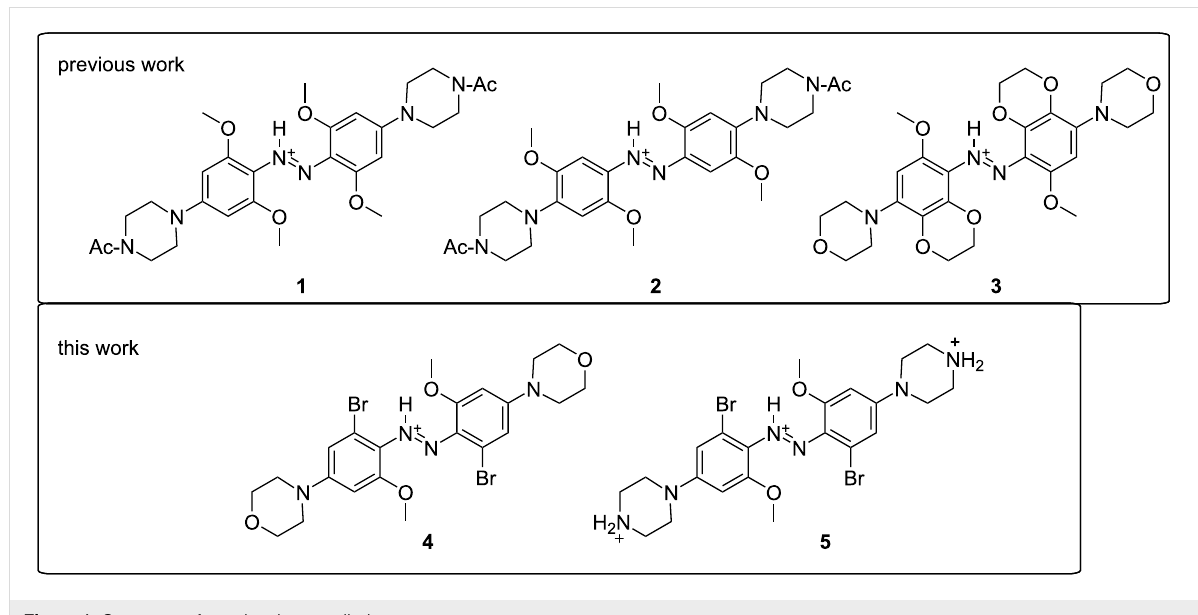
Figure 1: Structures of azonium ions studied.